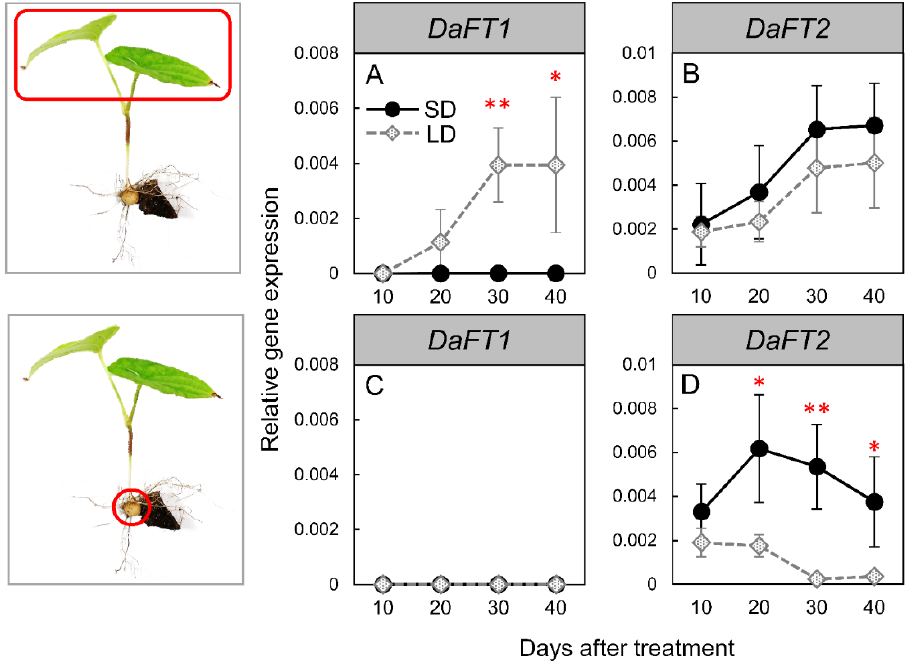
Figure 3. Relative expression of FT -like genes, ( A , C ) DaFT1 and ( B , D ) DaFT2 , in leaves and tubers under the short-day (SD: 10 h daylength) and long-day conditions (LD: 14 h daylength). Values are the means ± S.D of 3 – 5 biological replications derived from different plants. * p < 0.05, ** p < 0.01 by Student’s t -test.